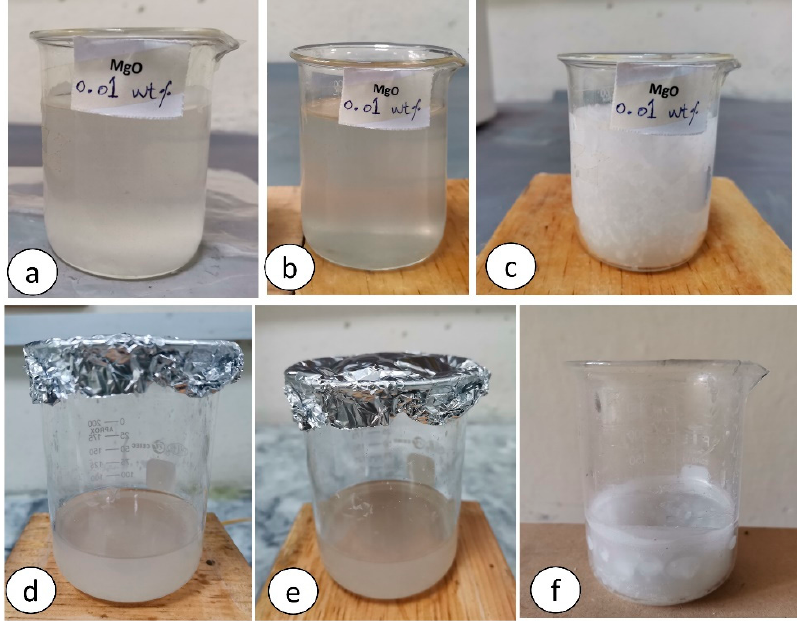
Figure 9. MgO samples: [0.01 wt. % ( a ) after preparation; ( b ) after 30 min; ( c ) in solid form]; [0.02 wt. % ( d ) after preparation; ( e ) after 30 min; ( f ) in solid form].